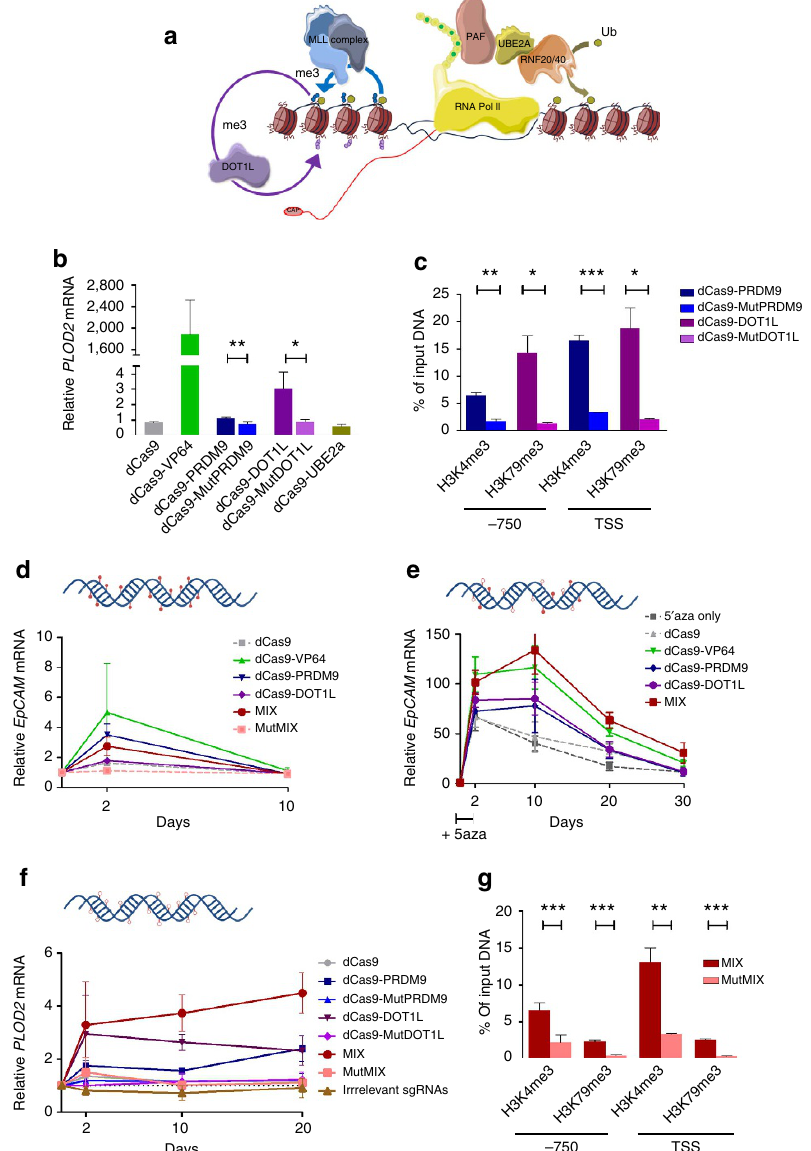
Figure 6 | Achieving sustained gene re-expression using different epigenetic editors. ( a ) Graphical representation of the process of gene transcription with the main epigenetic players; RNA polymerase II recruits the ubiquitin-conjugating and -ligating enzyme via PAF to monoubiquitinate H2B, this ubiquitination is required for H3K4me3 and H3K79me. ( b ) Relative PLOD2 messenger RNA (mRNA) expression, after co-transfection of dCas9 fusions and a combination of gRNAs. ( c ) H3K4me3 and H3K79me3 ChIP–qPCR enrichment at the promoter region of PLOD2 (around TSS and 750bp upstream. ( d ) Relative EpCAM mRNA, after co-transfection in HeLa cells of dCas9 fusions and a combination of gRNAs. ( e ) Relative EpCAM mRNA, after co-transfection in HeLa cells of dCas9 fusions and a combination of gRNAs and 5 0 aza treatment. ( f ) Relative PLOD2 mRNA, after co-transfection in C33a cells of dCas9 fusions and a combination of gRNAs. ( g ) H3K4me3 and H3K79me3 ChIP–qPCR enrichment at the promoter region of PLOD2 20 days after seeding cells around TSS and 750bp upstream (two-tailed unpaired t -test, * P o 0.05, ** P o 0.01, *** P o 0.001). n ¼ 3 independent experiments; error bars ±